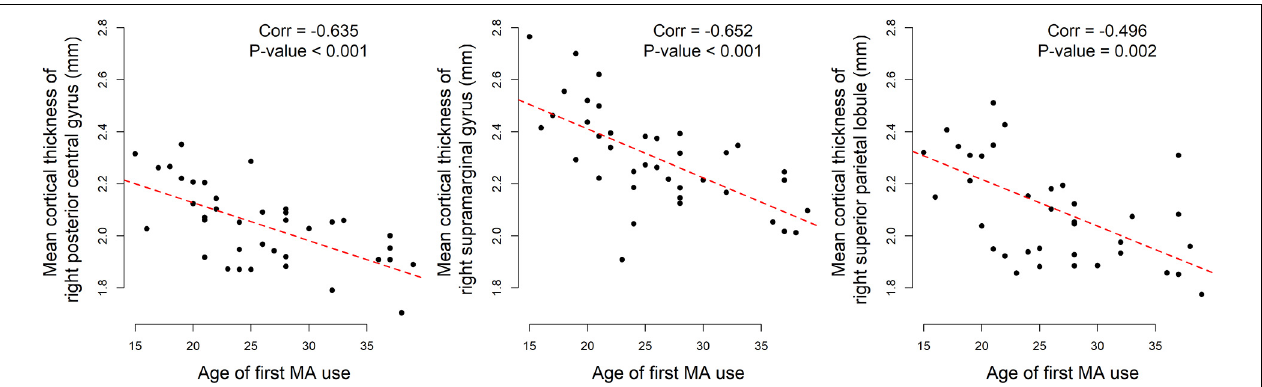
FIGURE 2 | Significant correlations between age of first MA use and mean cortical thickness of abnormal regions in AMD group.